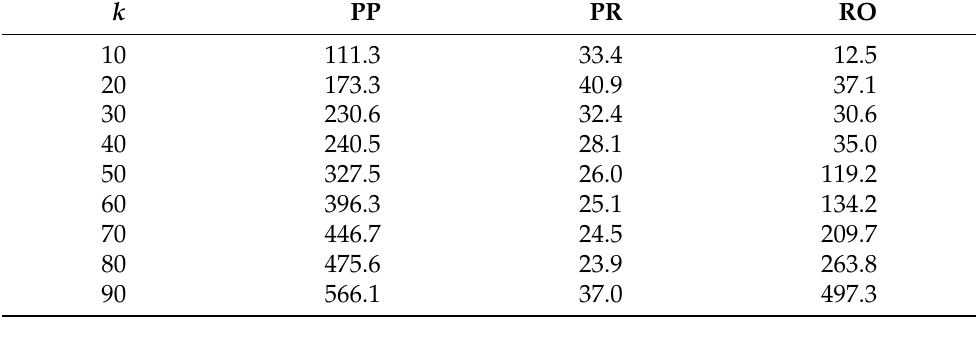
Table 3. Average out-of-sample performance with different sample size in the k NN.